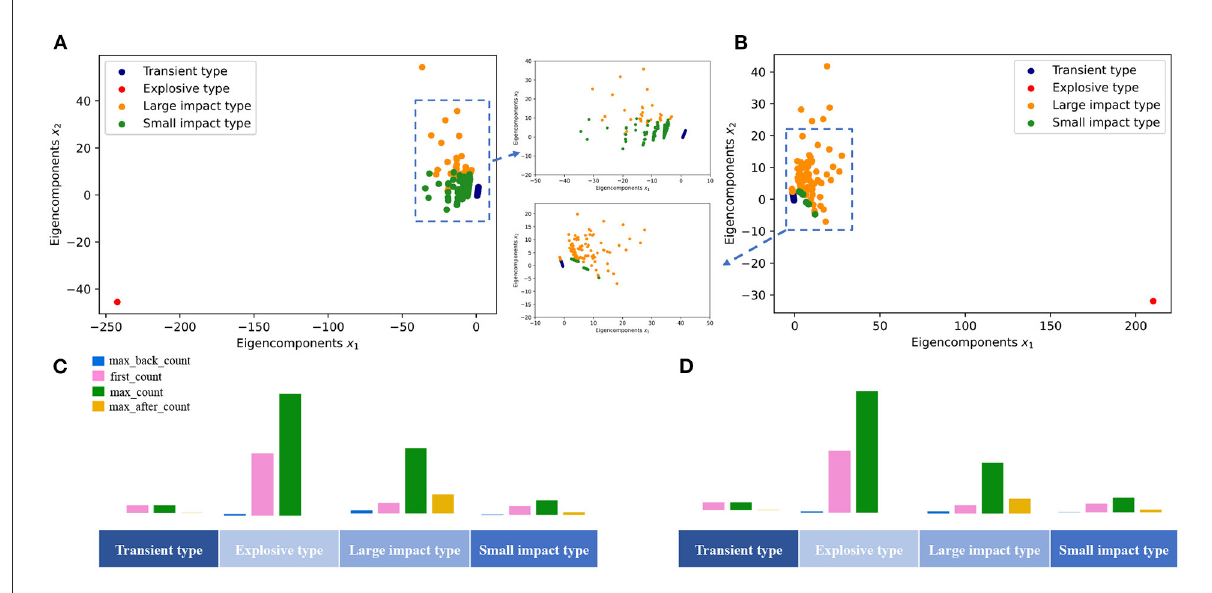
FIGURE5 Results of clustering using two other classical clustering methods. (A) Agglomeration clustering results. (B) GMM clustering results. (C) Distribution of each cluster with Agglomeration clustering. (D) Distribution of each cluster with GMM